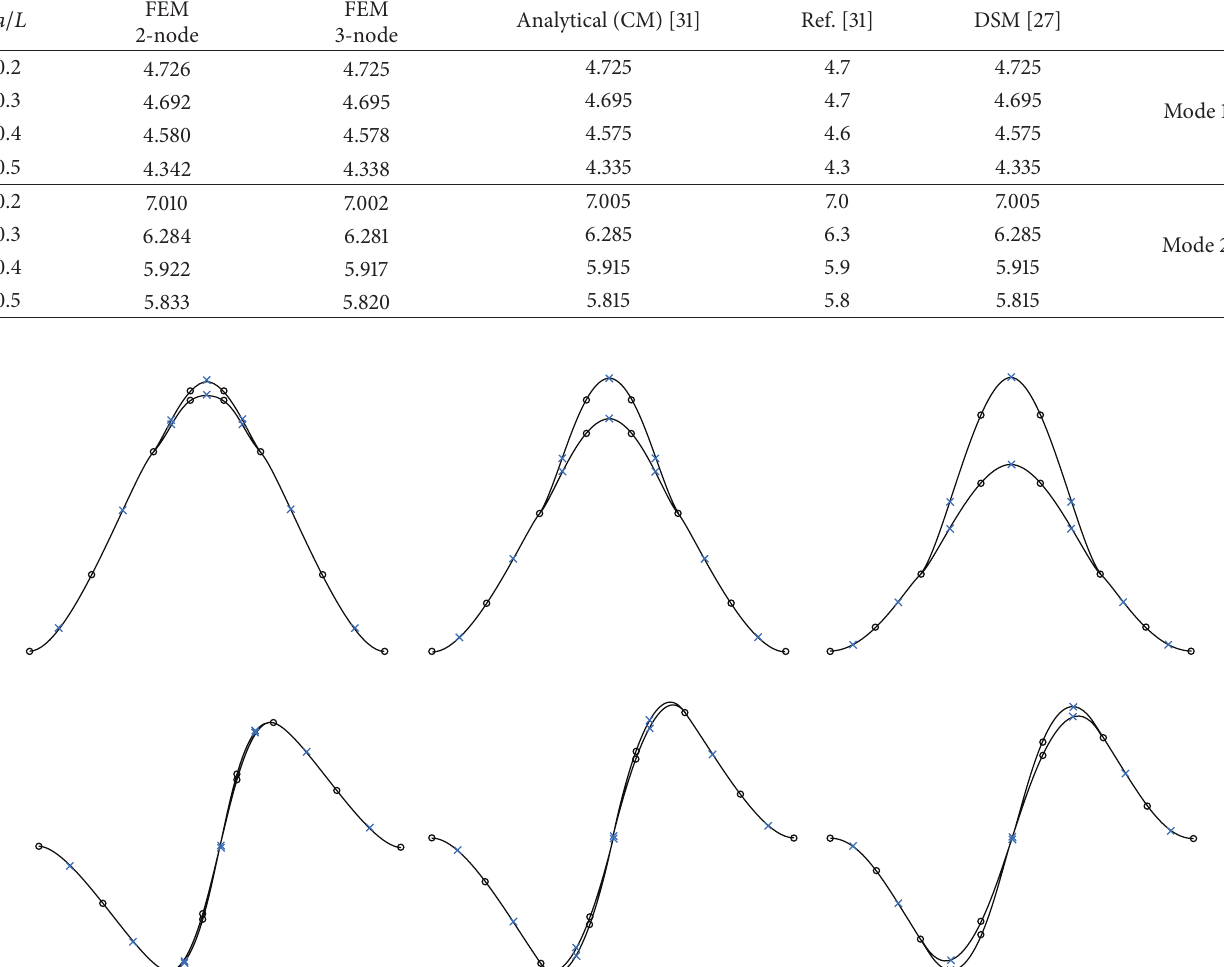
Table 4: The first and second nondimensional frequency parameter ( 𝜆 ) for model 2.